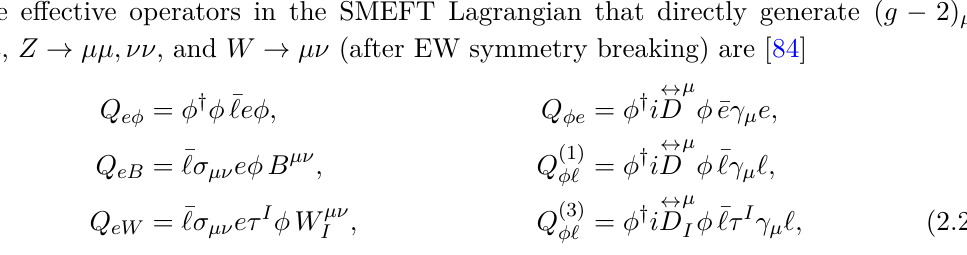
Figure 1 . Diagrams contributing to the matching of the simplified models onto the SMEFT operators (2.2). The first line is relevant for Q eφ , the second for Q eB , Q eW , and the third for Q (1) Q (3) (the diagrams for Q φe follow from ‘ → e and L ↔ E ). In the third and fourth diagram the φ‘ gauge boson is understood to couple at all possible places, while the gray blob in the fifth diagram denotes the full tree-level scalar QED amplitude. Note that after SU(2) L breaking the second and fifth diagram only contribute to on-shell decays but not to effective h , W , and Z couplings at zero momentum